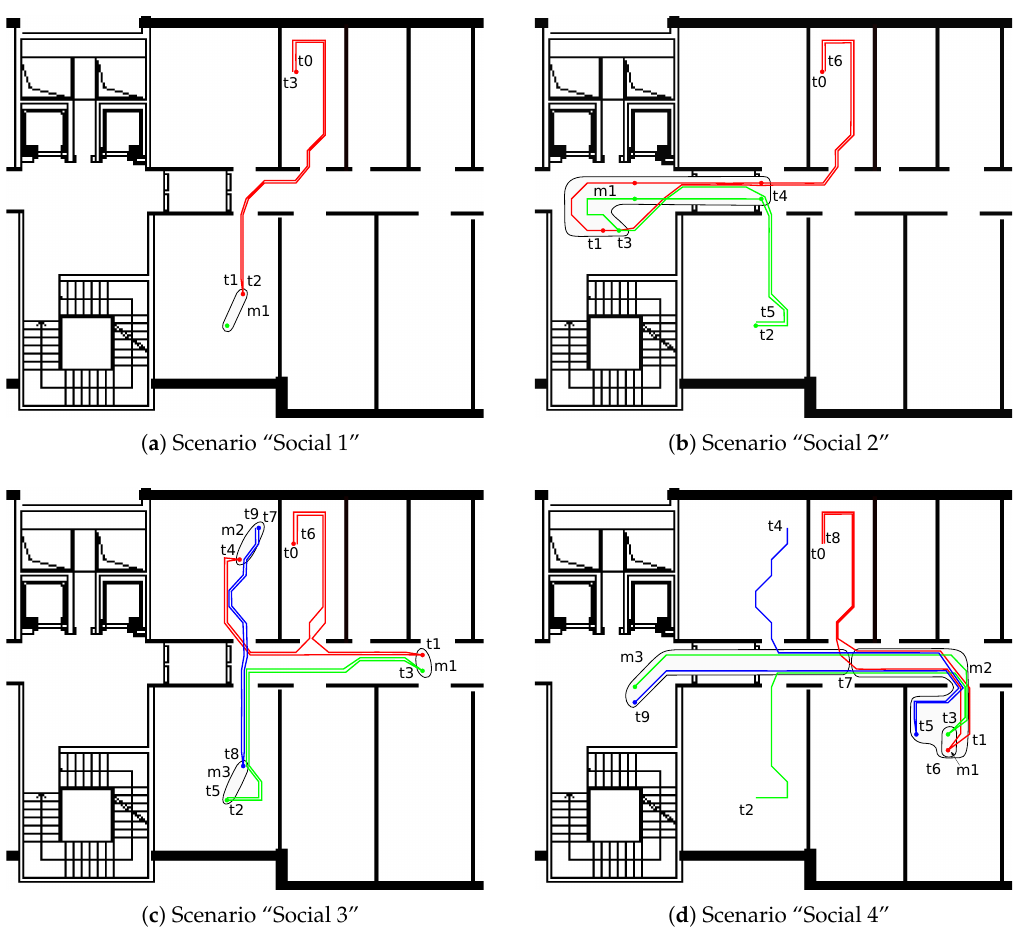
Figure 3. The four social interaction scenarios. Actors’ paths are indicated with different colors: red (Actor 1), green (Actor 2), and blue (Actor 3). Interactions indicated with gray areas m i at time t i . In total, we labeled 866 positions for each experimental campaign at three different transmission powers (3 dBm, − 6 dBm, and − 18 dBm) for a total of 2598 labeled points, obtaining almost three millions labeled RSSI values over 229 min of data collection campaign, with almost one hour of social interaction events. Table 1 provides additional details about the collected data. It should be noted that the overall duration and the total number of labeled positions are expressed as the sum of the three campaigns using different transmission powers (e.g., for the “Survey” scenario, each campaign lasted approximately 38 min collecting samples in each of the 277 points in the map shown in Figure 1). Furthermore, the amount of collected RSSI values is much less than what was transmitted due to the presence of packet loss, as explained in Section